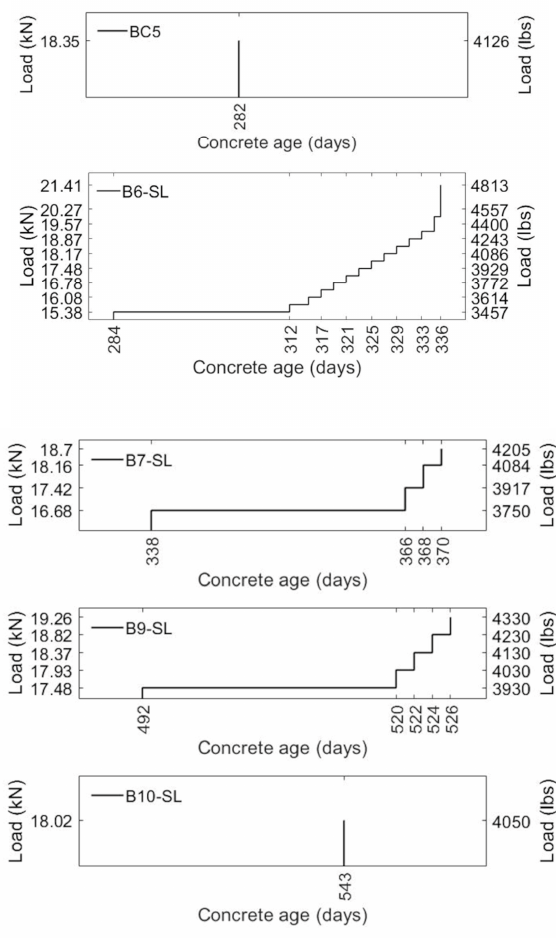
Figure 8. Beam series II loading histories.